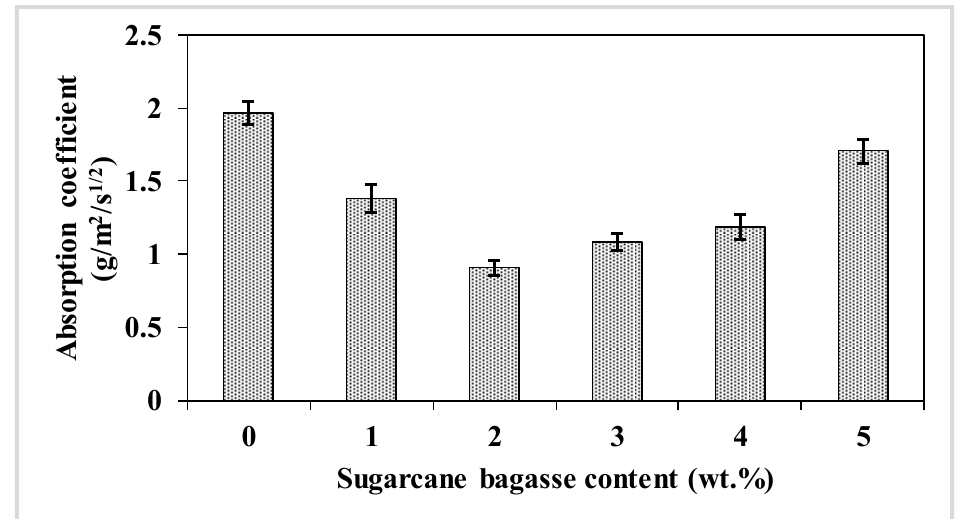
Figure 11. Absorption coefficient of adobes versus sugarcane bagasse content. The coefficient of water absorption by capillarity in adobes decreases until sugarcane bagasse additions reach 2 wt.%. This decrease is due to the homogeneous microstructure of adobes reinforced by sugarcane bagasse, with few pores. Beyond 2 wt.% of sugarcane bagasse, the absorption coefficient increases due to the packing of the sugarcane bagasse in the clay matrix. At this sugarcane bagasse content, the hydrophilic effect of the hemi- celluloses contained in the bagasse can be observed, and the capillary water absorption in the adobe composite thus increases. Pictures of adobes immersed in water for 96 h are presented in Figure 12.